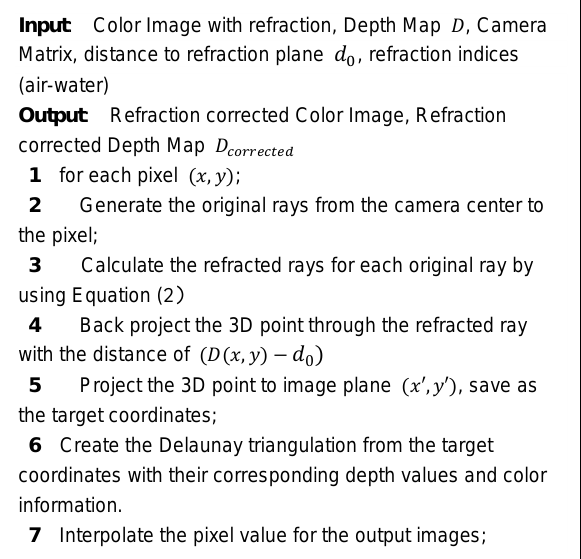
Figure 4. Pseudo-code of refraction correction algorithm Refraction correction accesses the known depth value for